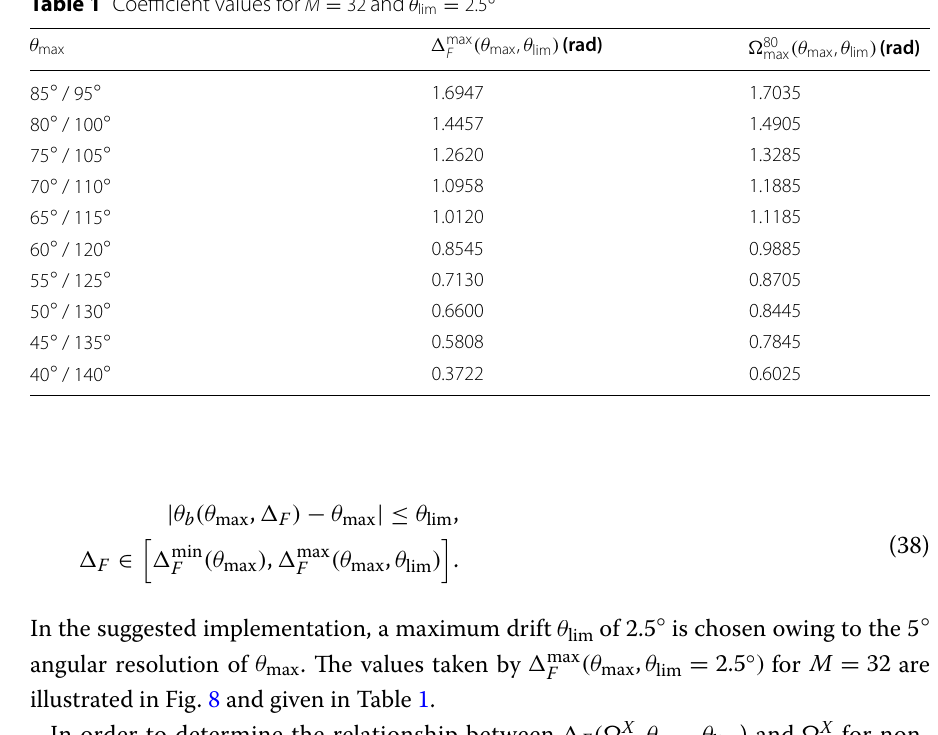
Table 1 Coefficient values for M